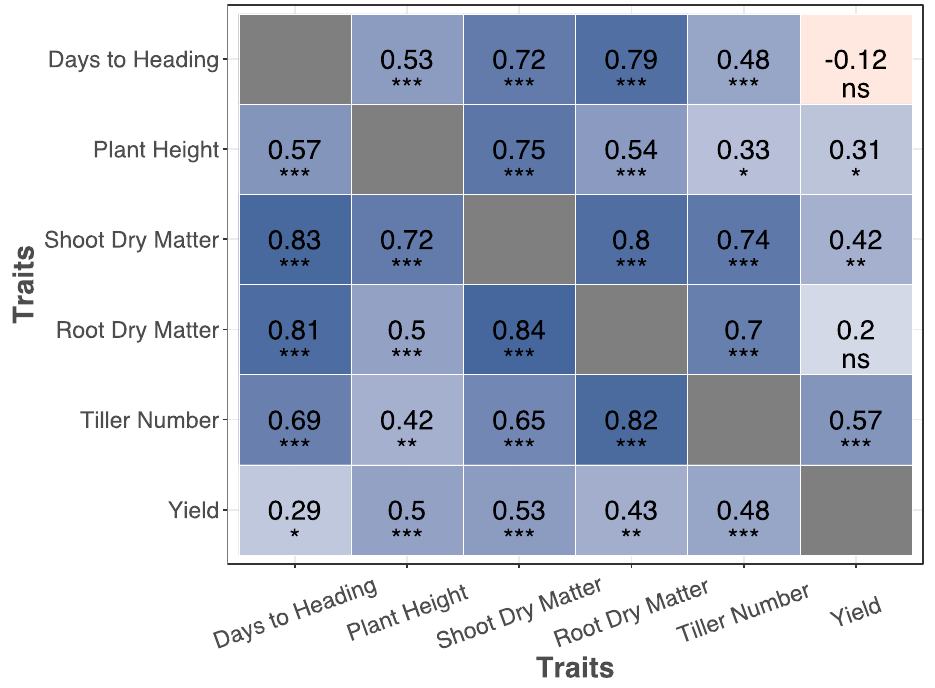
Figure 4. Matrix displaying the correlations and significance of traits measured in the maturity assay. Red heatmap signify a negative correlation between the traits whereas blue heatmap represents a positive correlation. Above the diagonal represents the correlation of these traits in low N whereas below the diagonal represents the correlation of the traits in high N. p value significance of as follows: *** < 0.001; 0.001 < ** < 0.001; 0.01 < * < 0.05; ns > 0.1. Root dry matter ranged from 0.12 to 1.81 g, with an average of 0.78 g in high N, and showed variable responses among various lines to low N (Figures 3 and 5). Similar to the dependency of shoot dry matter, we observed considerable correlations between root dry matter and the key phenological and anatomical traits. The correlation of duration of vegetative growth, tiller numbers, and plant height with root dry matter were 0.81, 0.82, and 0.50 in high N (Figure 4). The same numbers were 0.79, 0.70, and 0.54 in low N. Shoot dry matter, itself, was correlated to root dry matter r = 0.84 in high N and 0.80 in low N (Figure 4).